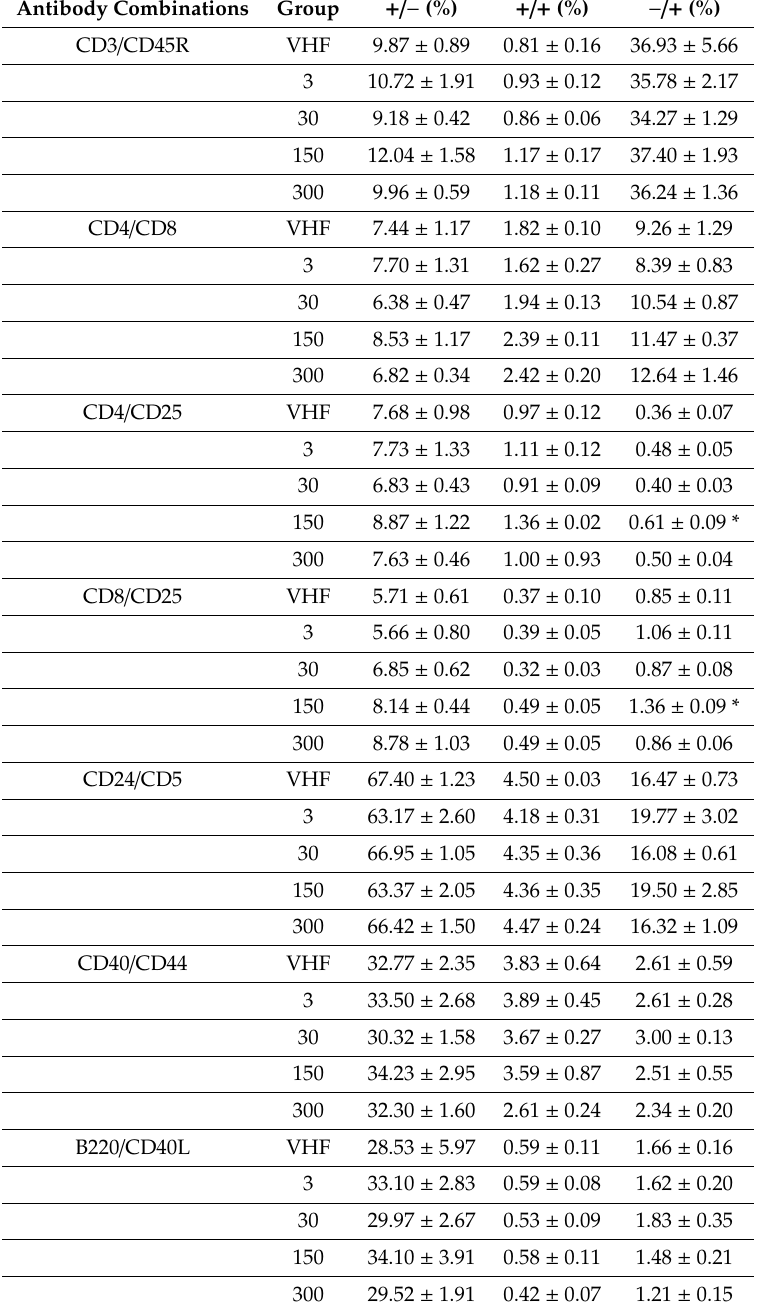
Table 1. Percentages of splenic immune cell populations in female NOD mice on the soy-based diet. Antibody